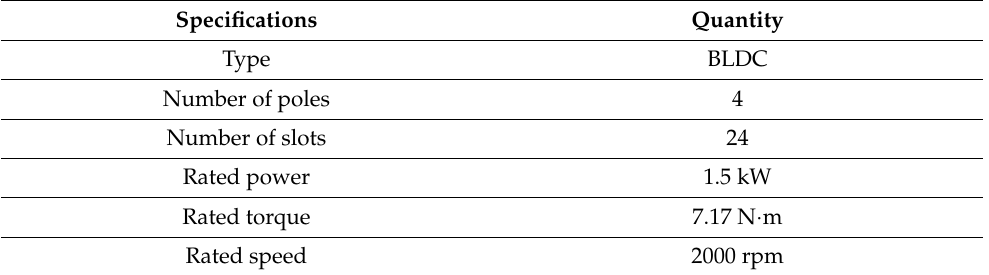
Table 1. Specifications of the BLDC